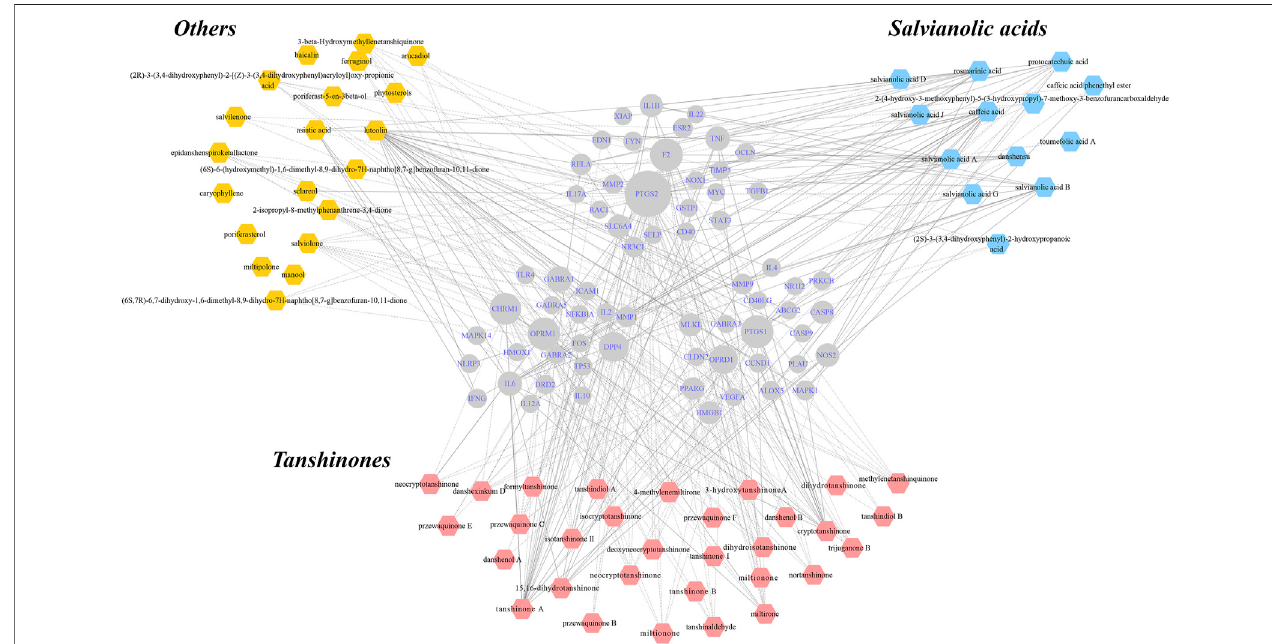
FIGURE 4 | Construction of “ herb-compound-target-disease ” network for unmasking underlying mechanisms of Danshen for in fl ammatory bowel disease (IBD). Eligible compounds of Danshen were characterized within three kinds of colors while the round shapes in the center represented intersected targets both of Danshen and IBD. The scale of hubs indicated degree of targets. Solid lines indicated interactions between certain compounds and targets that were supported in the literature.